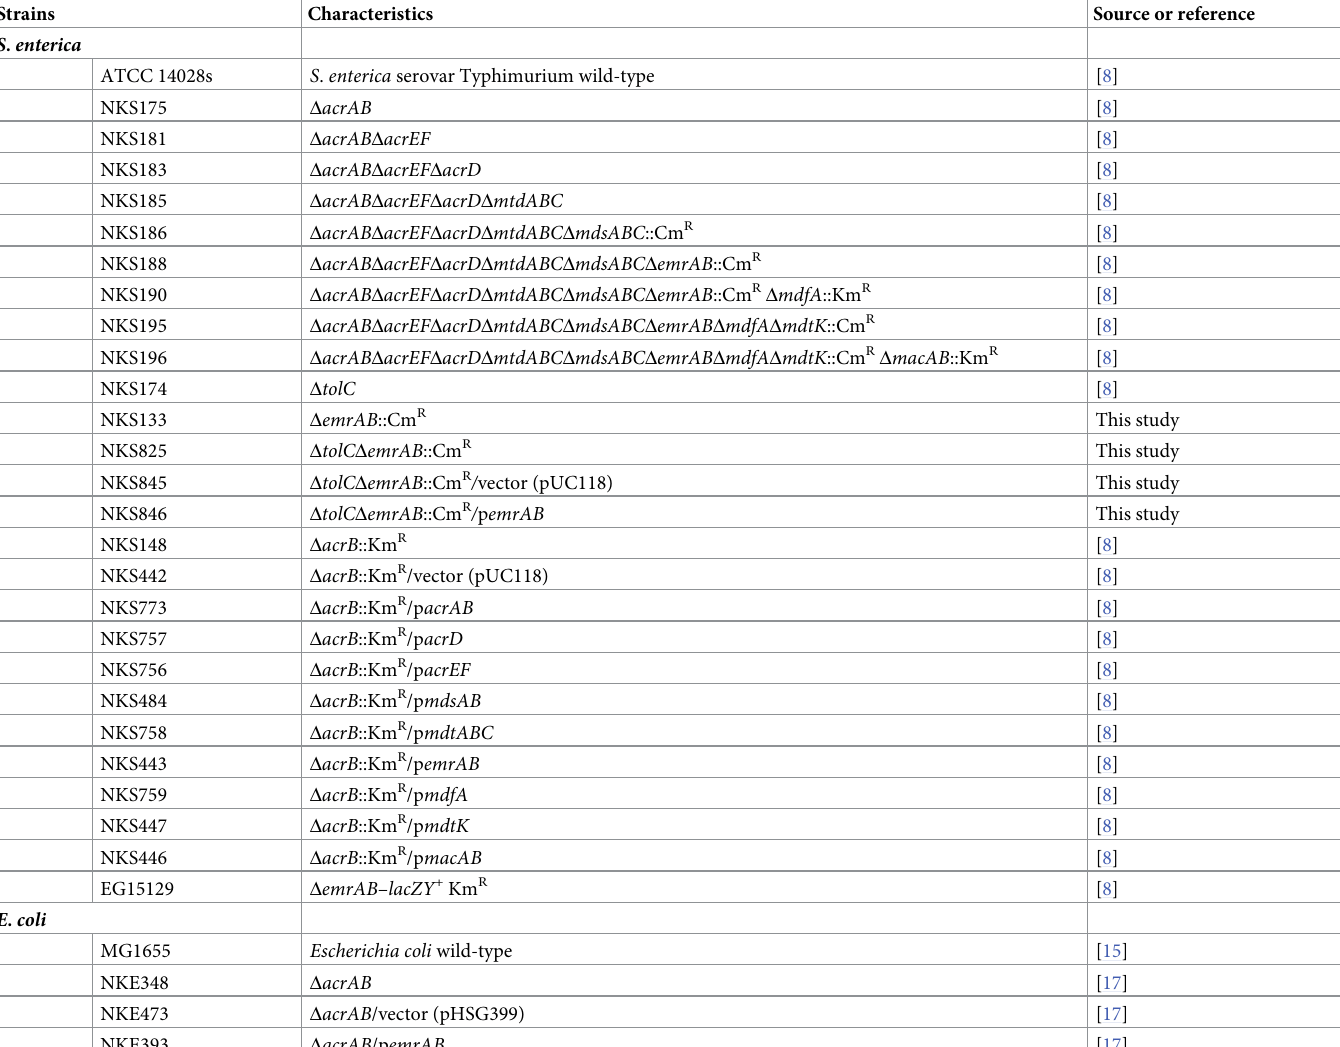
Table 1. Salmonella enterica and Escherichia coli strains used in this study. Strains